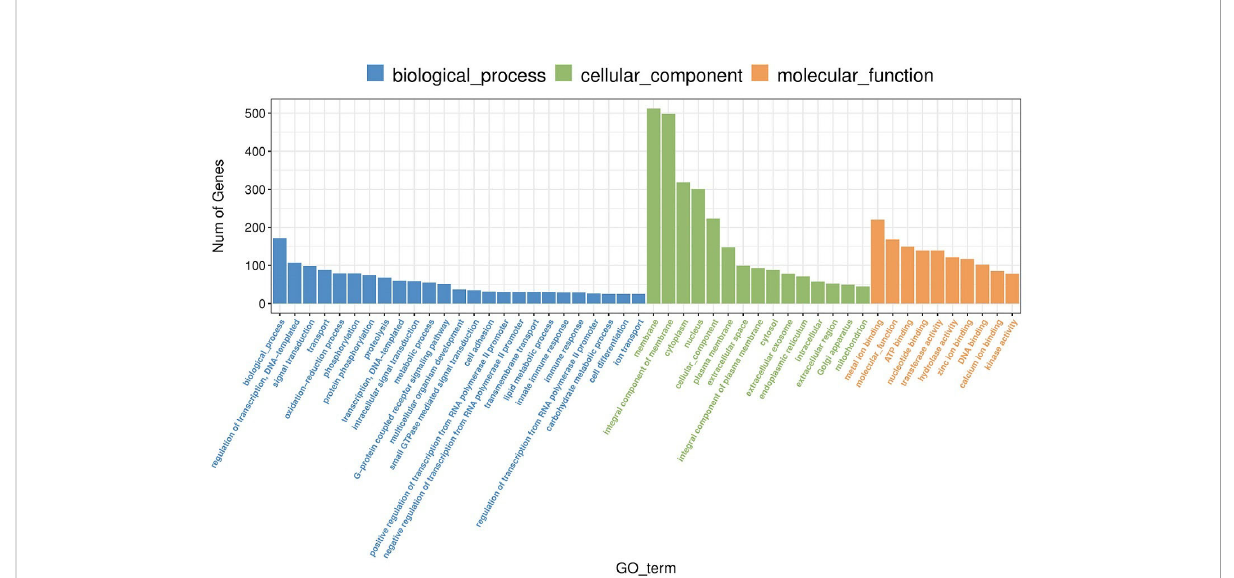
FIGURE 1 Go enrichement (top 25 of biological process, top 15 of cellular component, top 10 of molecular function) of signi fi cantly differentially expressed genes in juvenle fl ounder under MeHg